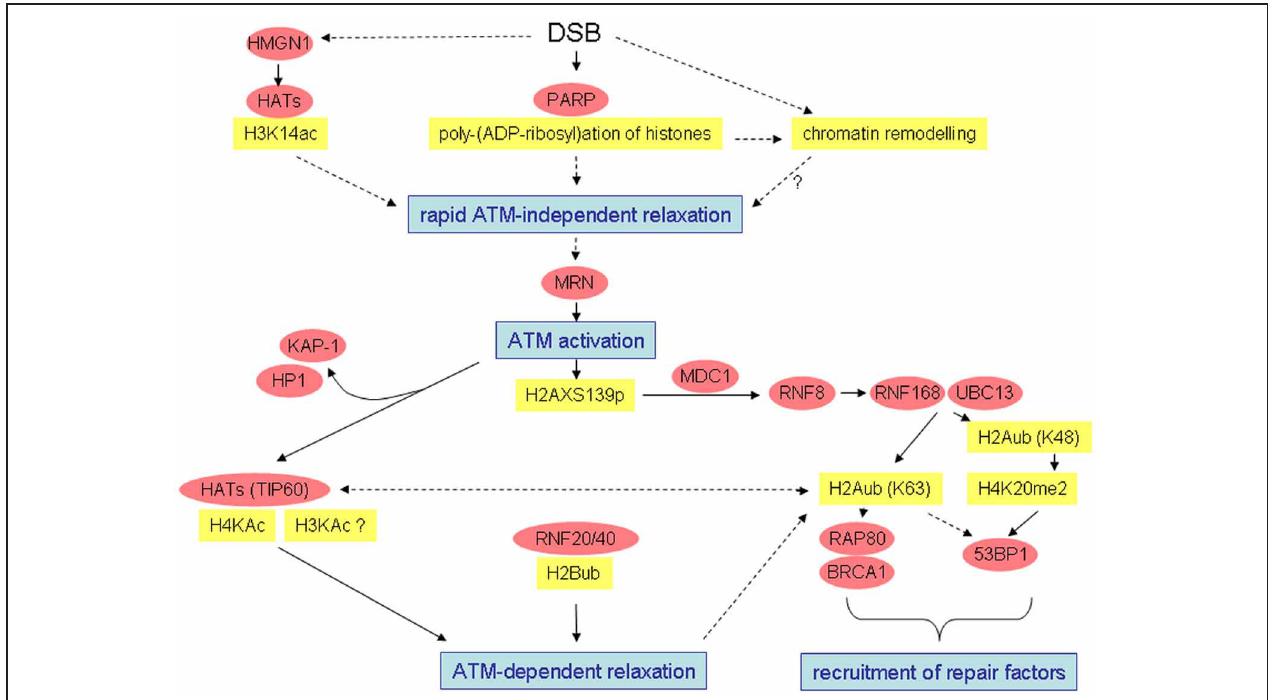
FIGURE 1 | Simplified overview of radiation-induced alterations possibly leading to open chromatin configuration or chromatin relaxation and recruitment of damage response factors. Well-characterized interactions and causal relationships are depicted by solid lines, less well-characterized interactions and relationships by broken